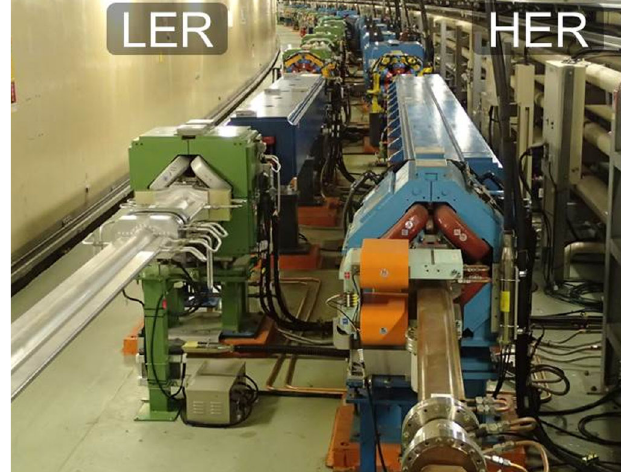
FIG. 2. Present view of the SuperKEKB